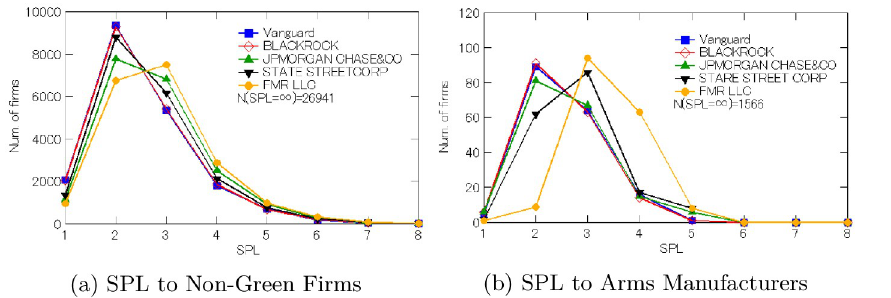
Fig 3. Shortest path length from American financial institutions to non-ESG